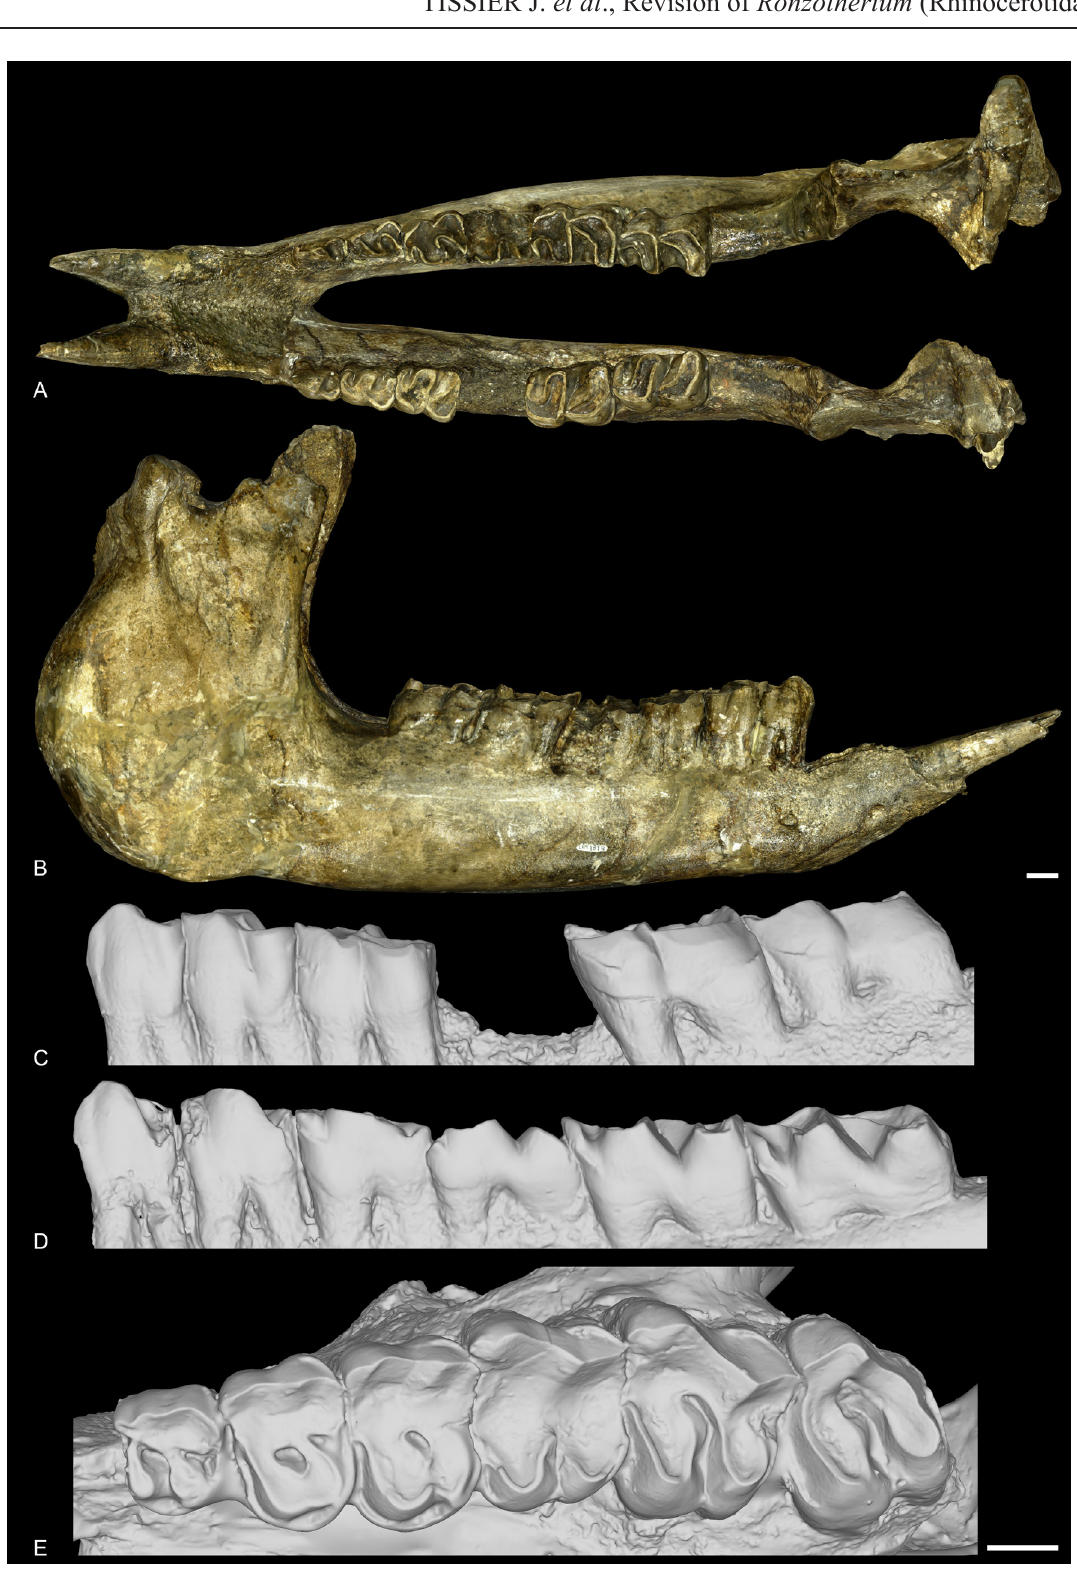
Fig. 24. Ronzotherium heissigi sp. nov. from Vendèze (late early Oligocene, France). A–D . Mandible MNHN.F.LIM181. A . Occlusal view. B . Lateral view. C . With left p2–p4 and m2–3 in labial view. View. D . Right p2–m3 in lingual view. – E . Skull MNHN.F.LIM181, belonging to the same individual as the mandible, close-up view of P2–M3 in occlusal view. Scale bars: 2